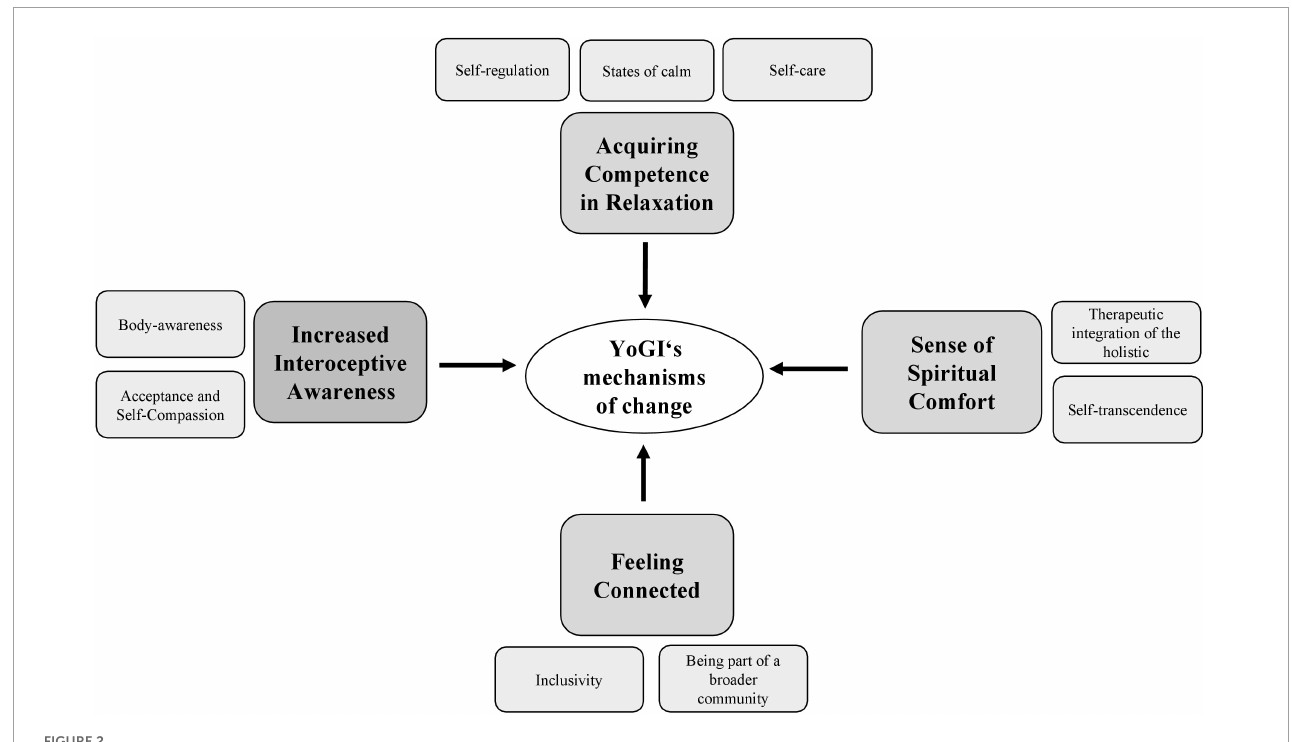
FIGURE2 Yoga-based group intervention (YoGI’s) mechanisms of